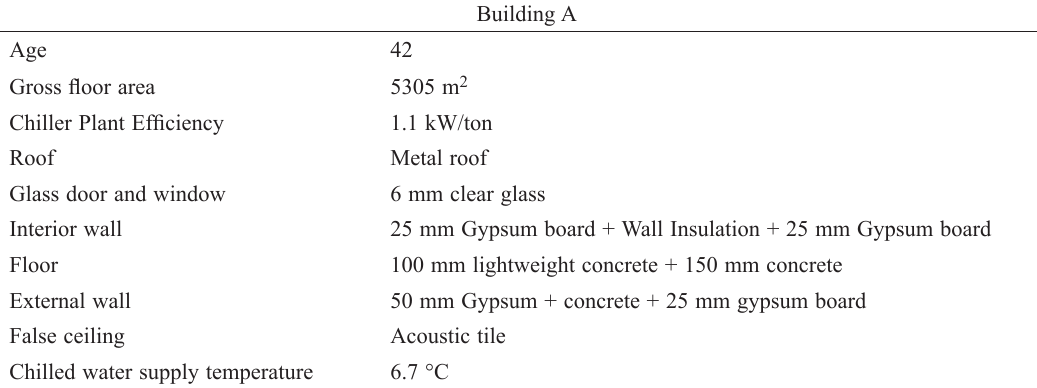
Table 1. Building characteristics